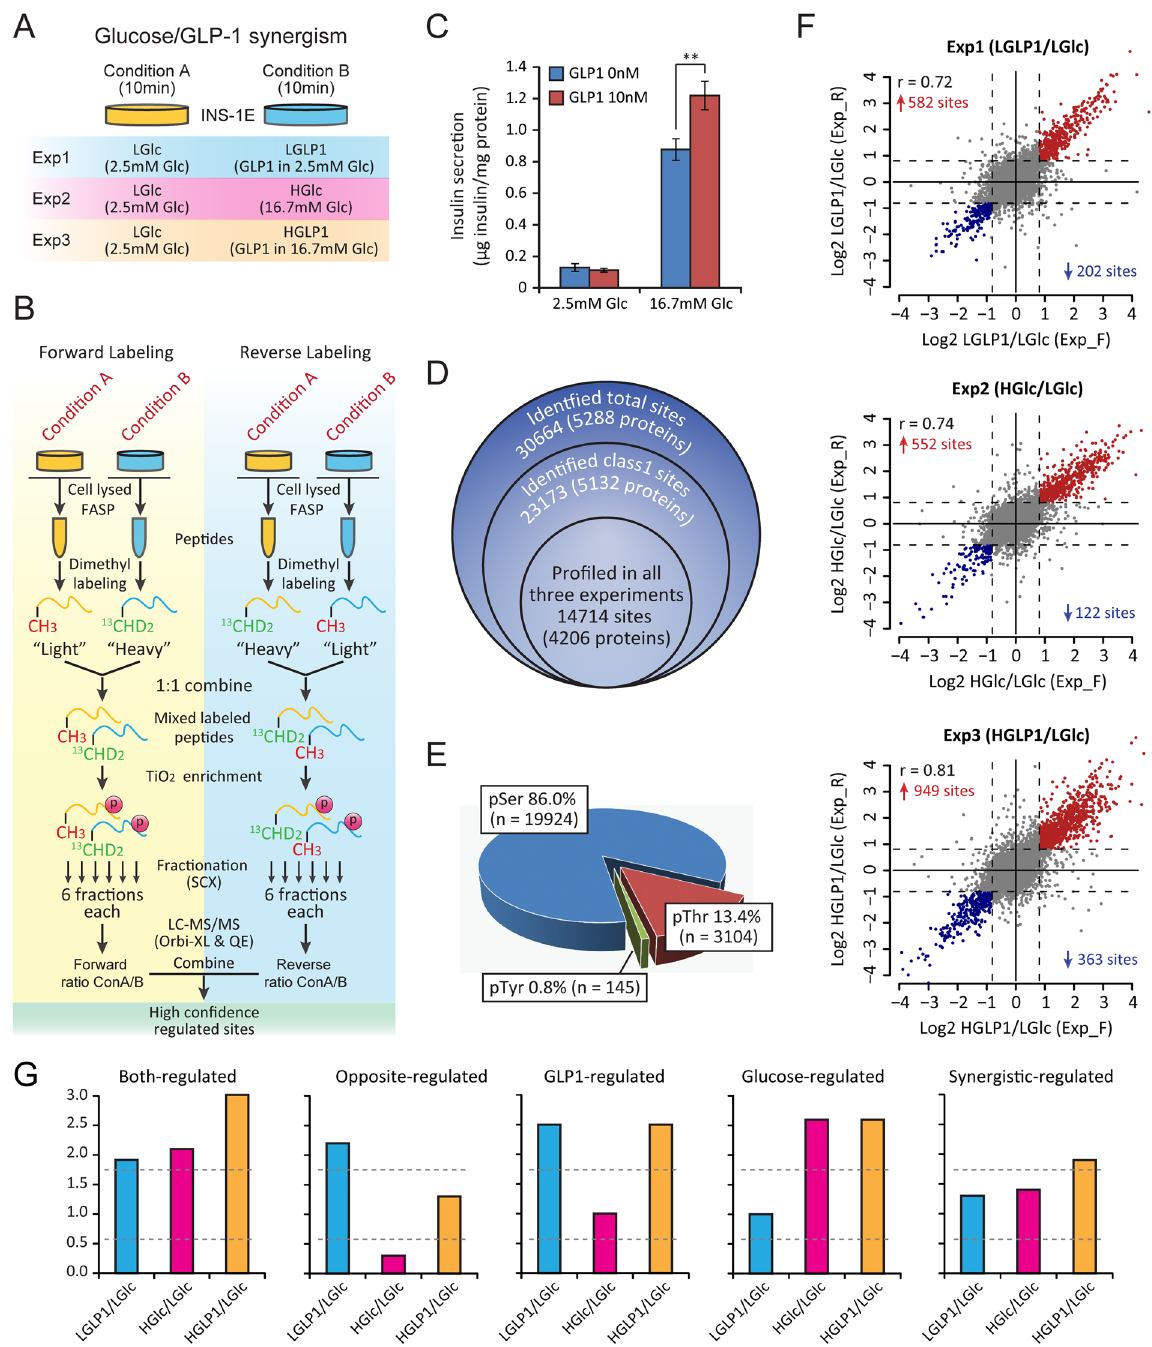
Figure 1. Quantification of the INS-1E cell phosphoproteome regulated by physiological secretagogues using tandem mass spectrometry. ( A ) Experimental design of the glucose/GLP-1 synergism experiment. Three experiments were contained in this set of experiments (Exp1 n = 4; Exp2 n = 4; Exp3 n = 4). ( B ) Workflow of the stable isotope dimethyl labeling-based quantitative phosphoproteomic analysis. (C) GLP-1 potentiates insulin secretion in a glucose dependent manner ( ** p < 0.01, Student’s t-test, n = 4, error bar: SEM). (D) Summary of identified and quantified phosphoproteome. (E) Distribution of accurately localized phosphorylated serine, threonine, and tyrosine residues in the combined data sets of all three experiments. (F) High-confidence regulated sites defined in all three experiments. Ratio condition B/A of each class 1 phosphorylation site determined in both forward and reverse labeling replicates are plotted. Down- or up- regulated phosphorylation sites are highlighted with blue and red spots respectively. Dashed line indicates 1.75-fold change threshold. Exp_F is short for forward labeling experiment, Exp_R is short for reversed labeling experiment. (G) Definition of phosphorylation regulation pattern mediated by GLP-1 (LGLP1), glucose (HGlc) and their synergism (HGLP1). The regulation pattern was divided into 5 classes. Dashed gray line indicates 1.75 fold change